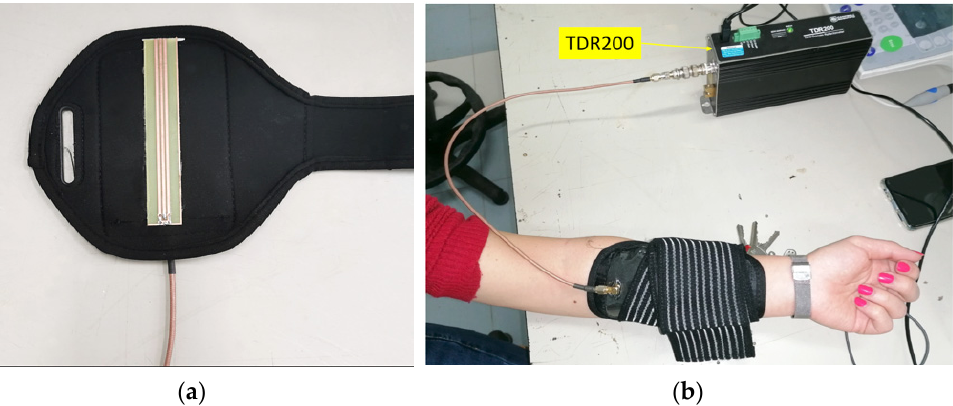
Figure 16. ( a ) SE attached to the inner surface of a smartphone bracelet running; ( b ) experimental setup for measuring human skin hydration [48].